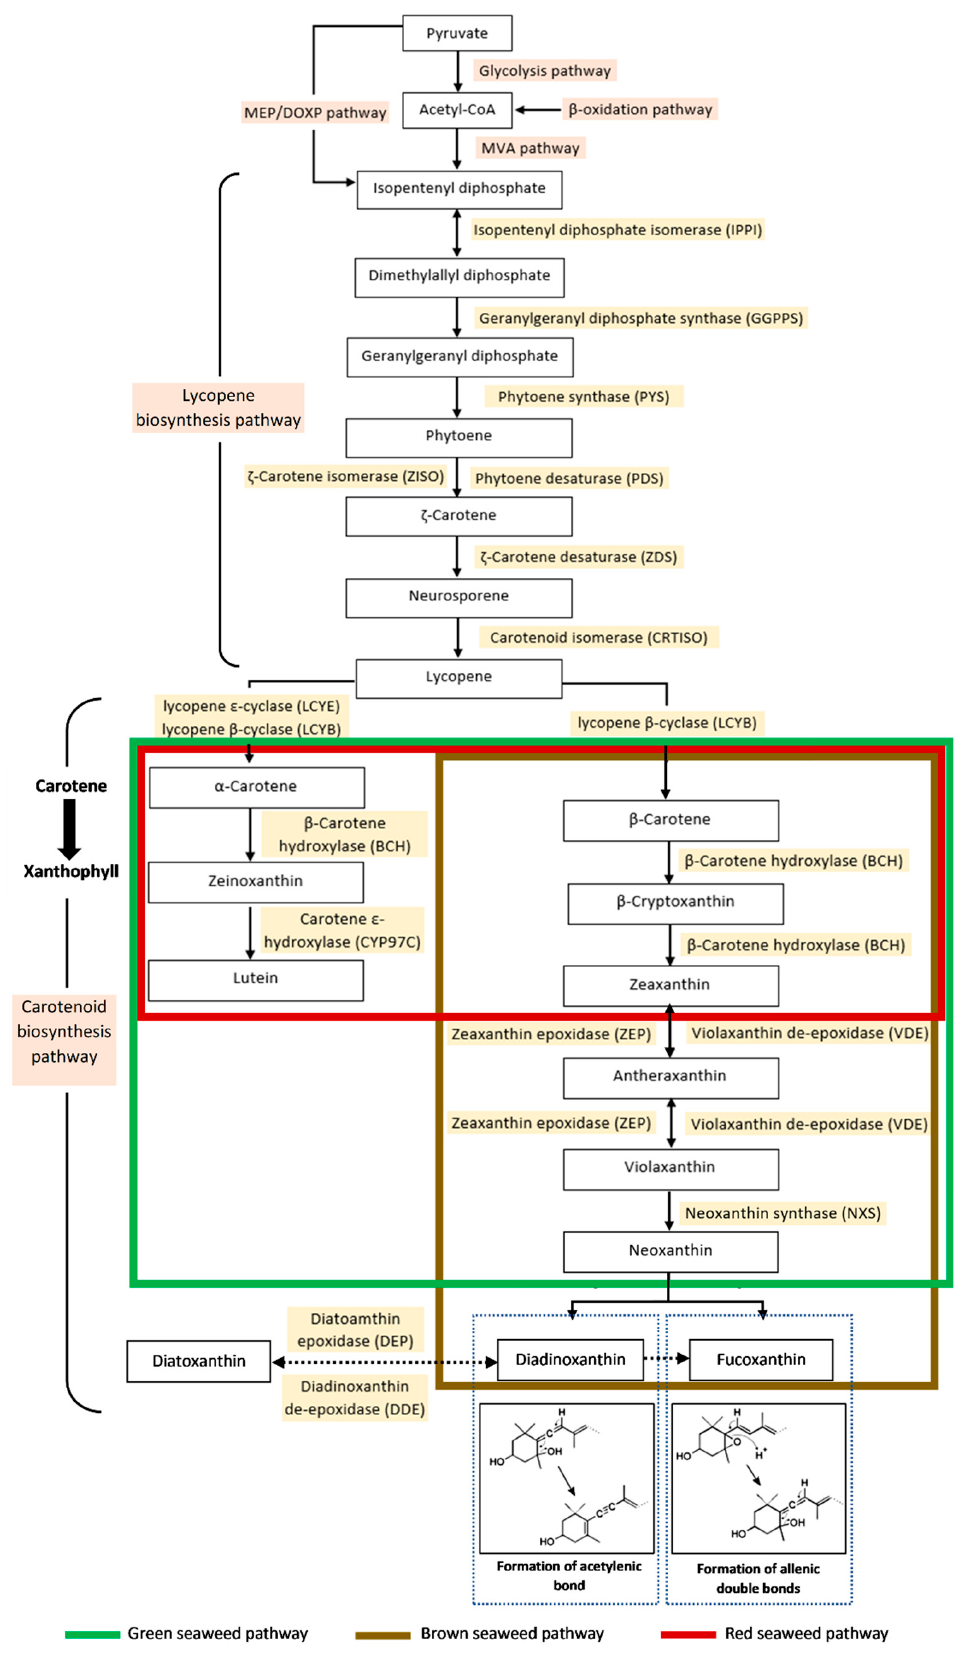
Figure 3. Carotenoid pathways in different seaweeds (Redrawn based on Mikami and Hosokawa [18] and Zarekarizi, Hoffmann and Burritt [36]).